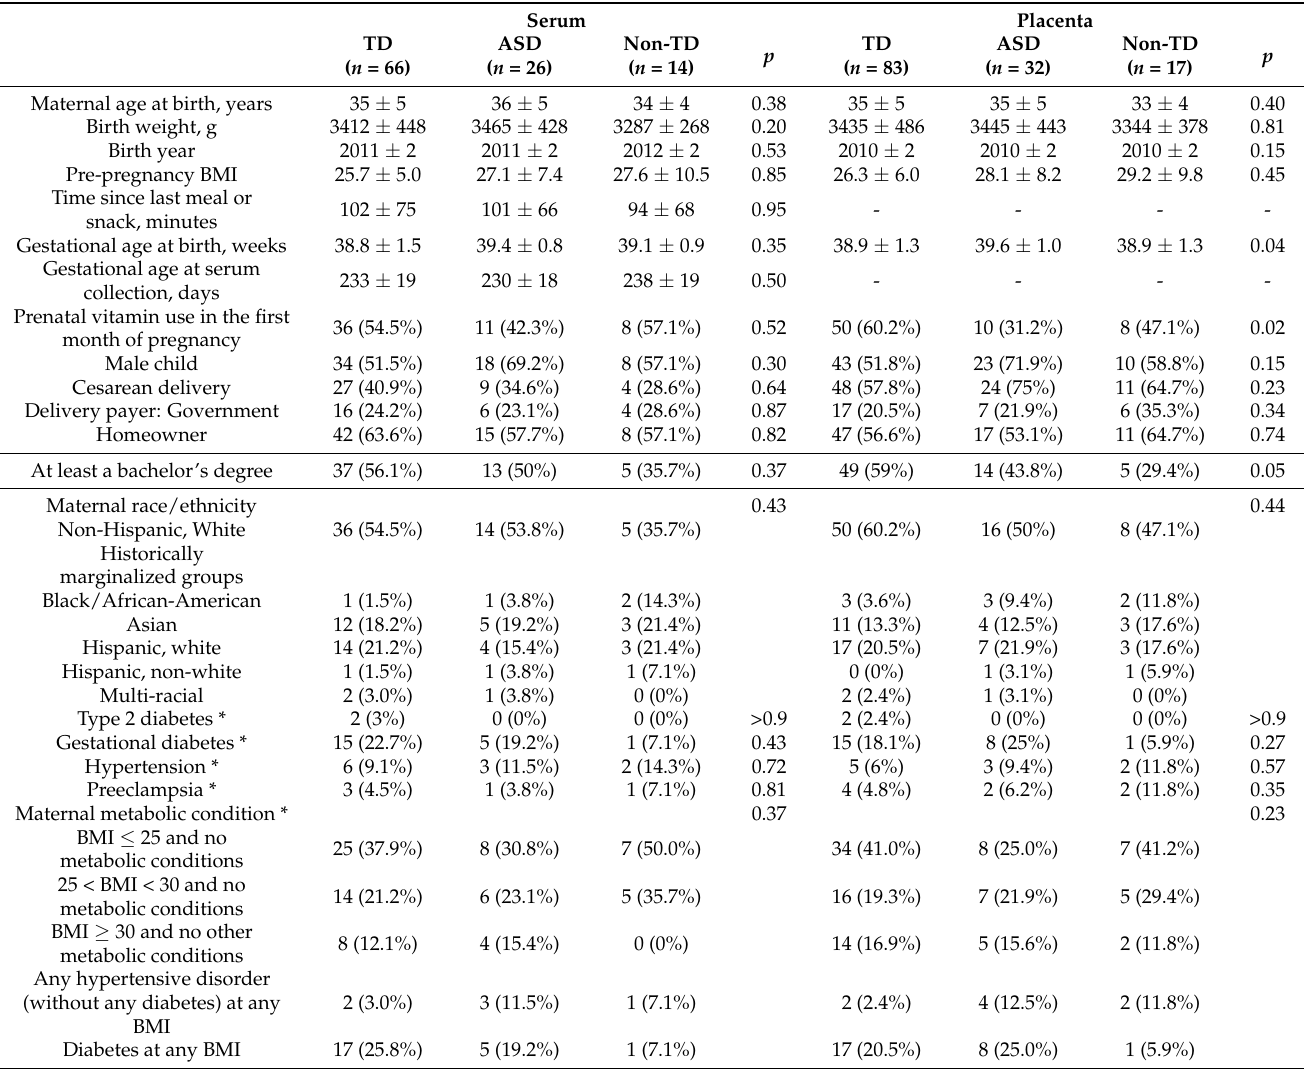
Table 1. Demographic characteristics of study subjects by the child of interest’s neurodevelopmental outcome: typically developing (TD), ASD, and non-typically developing (Non-TD). For each neu- rodevelopmental outcome, the mean ± standard deviation for continuous variables and proportion (count) for categorical variables are reported. Differences in maternal and child factors between neu- rodevelopmental groups were assessed using chi-squared tests for categorical variables (or Fisher’s exact test, indicated by *) and Kruskal–Wallis tests for continuous